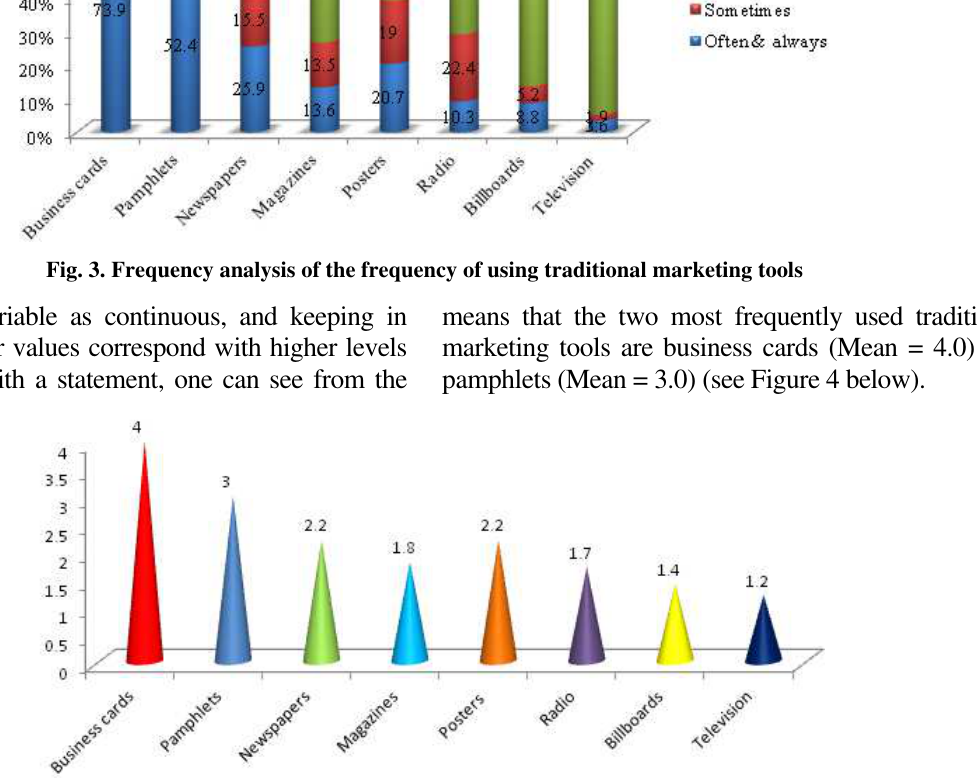
Fig. 4. Mean values of the ratings of the frequency of using traditional marketing tools